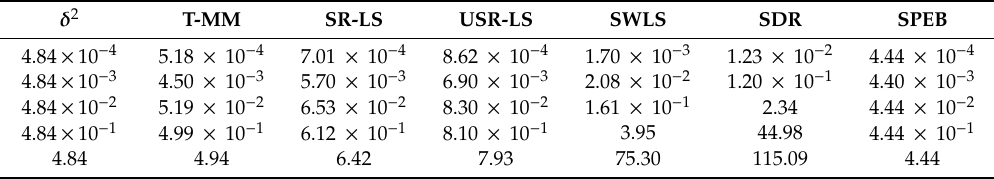
Figure 5. Conventional localization algorithm’s MSE comparison to the squared position error bound (SPEB) versus 𝛿 . Table 1. Mean square error of all localization algorithms .